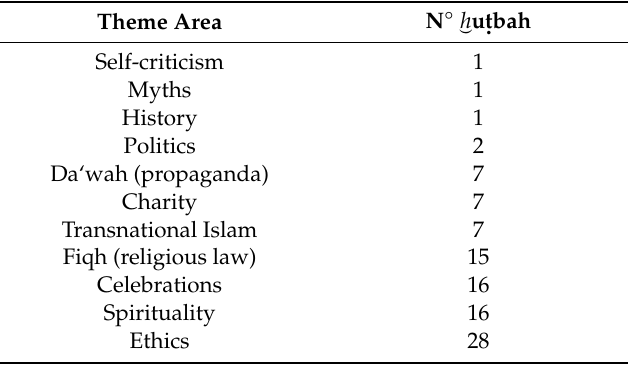
Table 1. Theme area by number of